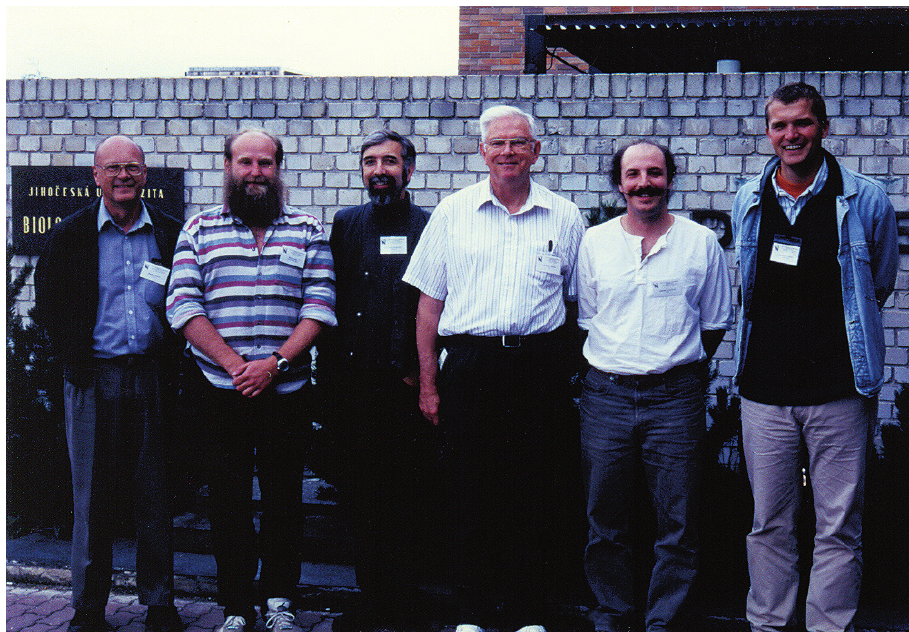
Figure 3. A few scolytine systematists at the VIth European Congress of Entomology, České Budějovice, Czech Republic, August 23–29, 1998. From left to right: Donald E. Bright, Miloš Knížek, Lawrence R. Kirkendall, Stephen L. Wood, Anthony I. Cognato, Christian Stauff